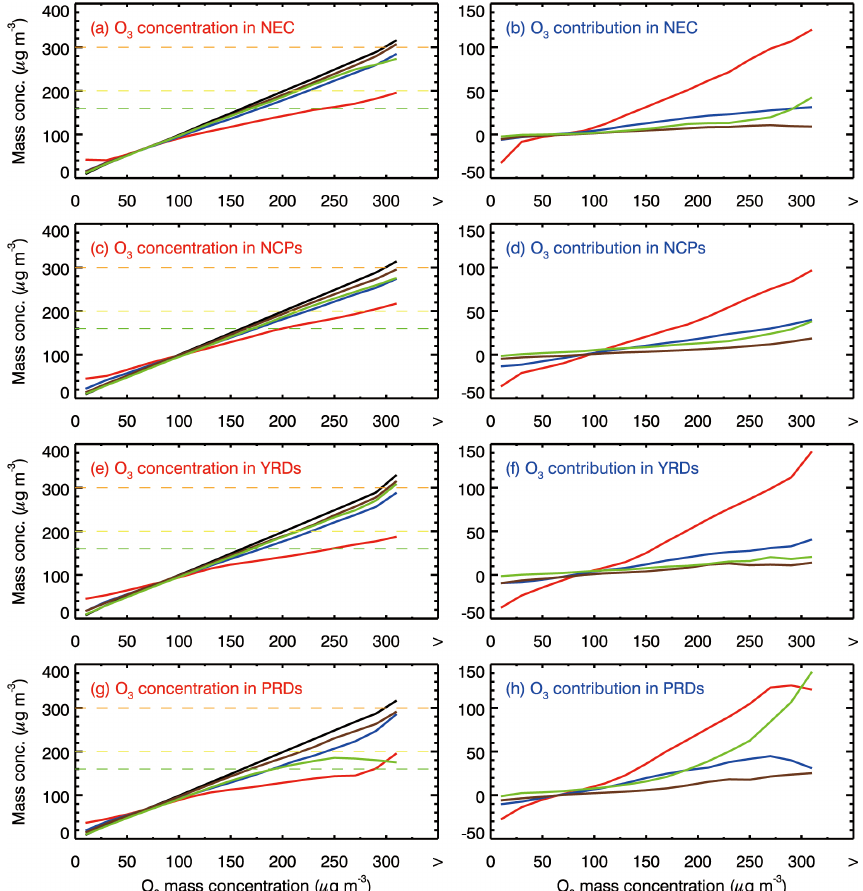
Figure 9. O 3 contributions of industry (red line), residential (brown line), transportation (blue line), and biogenic emissions (green line) in NEC, NCPs, YRDs, and PRDs, as a function of simulated [O 3 ] in the control case.